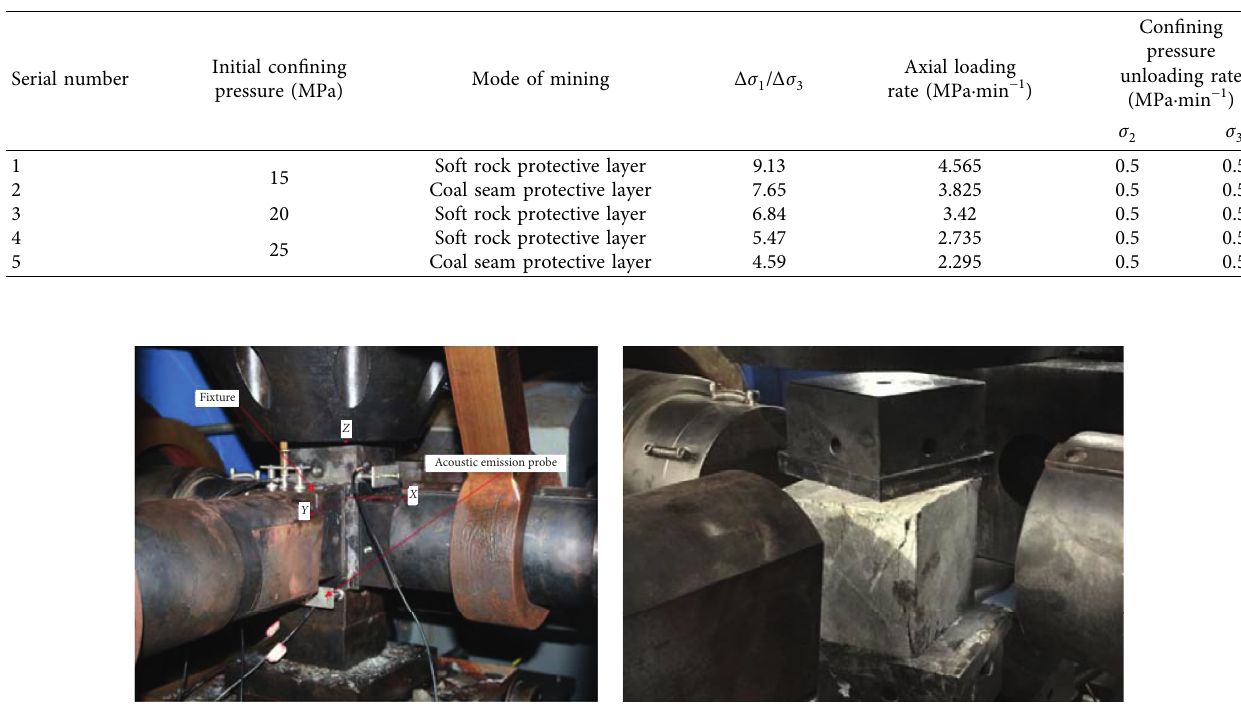
Table 2: Experimental plan table.